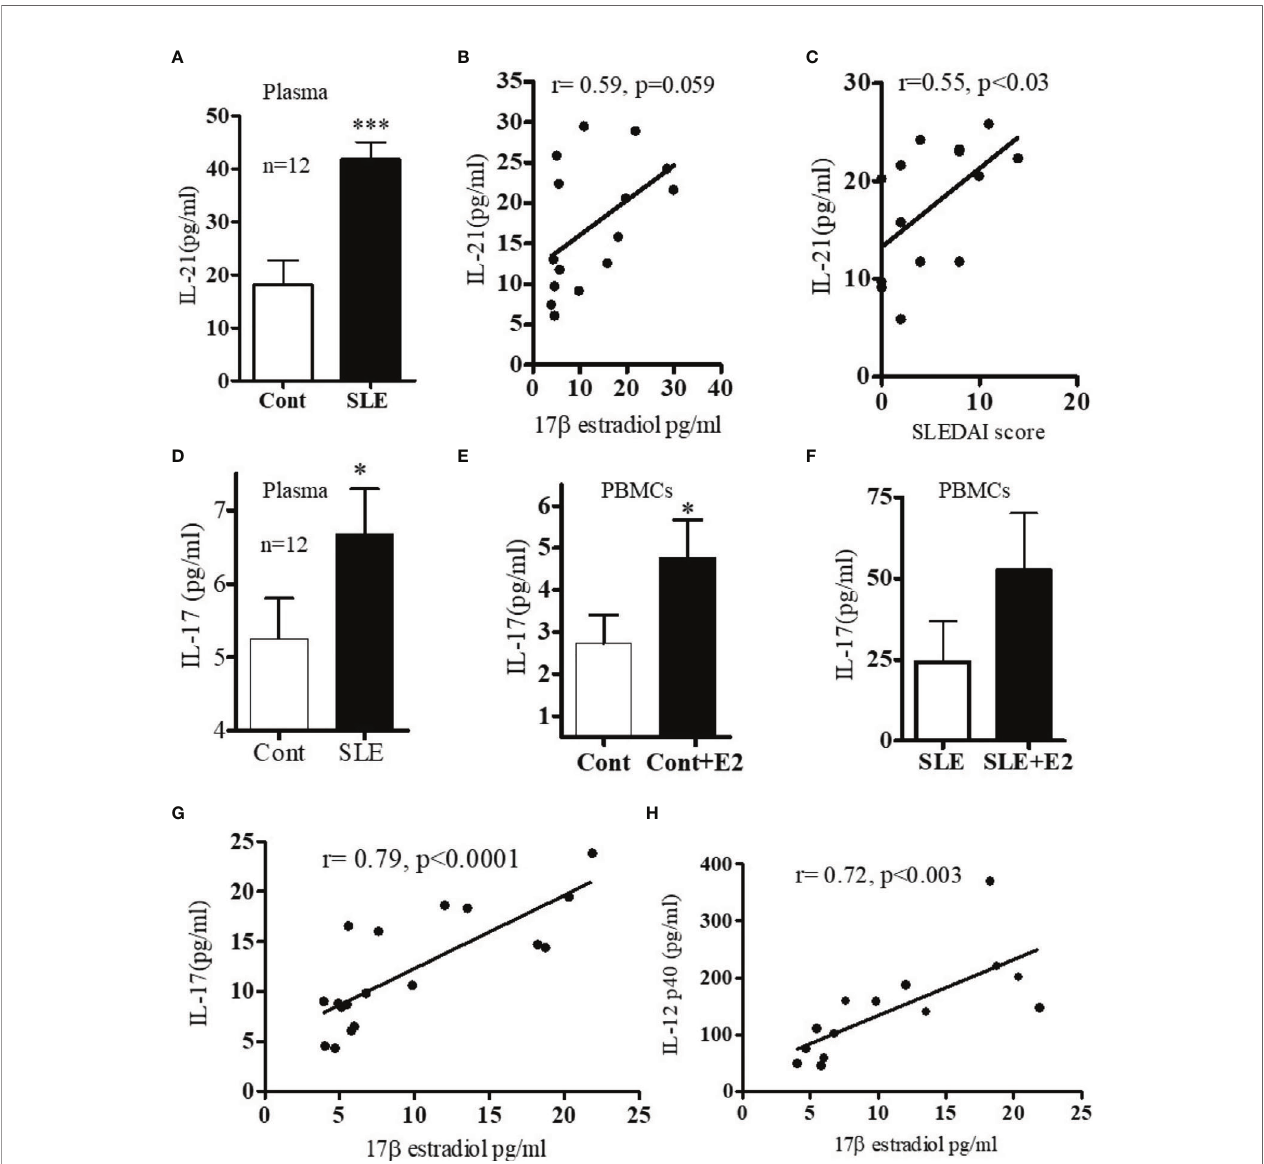
(C) Correlation between IL-21 levels and SLEDAI (SLE disease activity index) score in SLE female patients (n=14). (D) IL-17 protein levels in healthy controls (n=12) vs female SLE patients ’ (n=12) plasma. (E) IL-17 protein levels measured from supernatant of PBMCs of healthy (n=11) controls PBMCs culture vs healthy